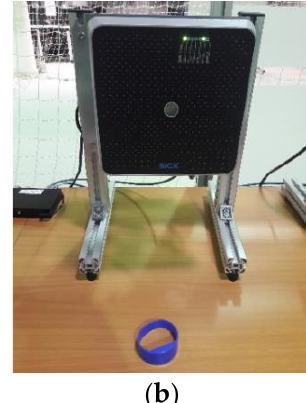
Figure 8. PC Platform improved with UHF RFID system: ( a ) Connections; ( b ) Implementation.